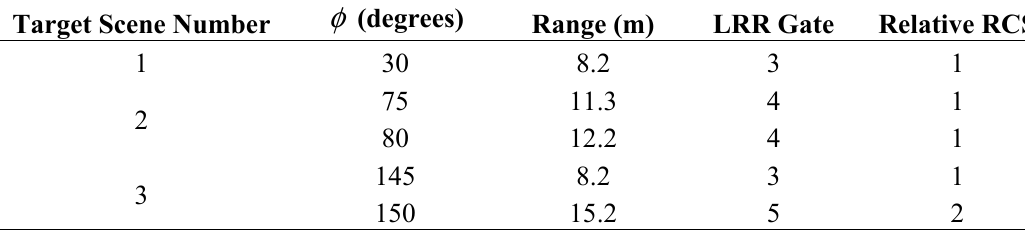
Table 9. Target Scenario